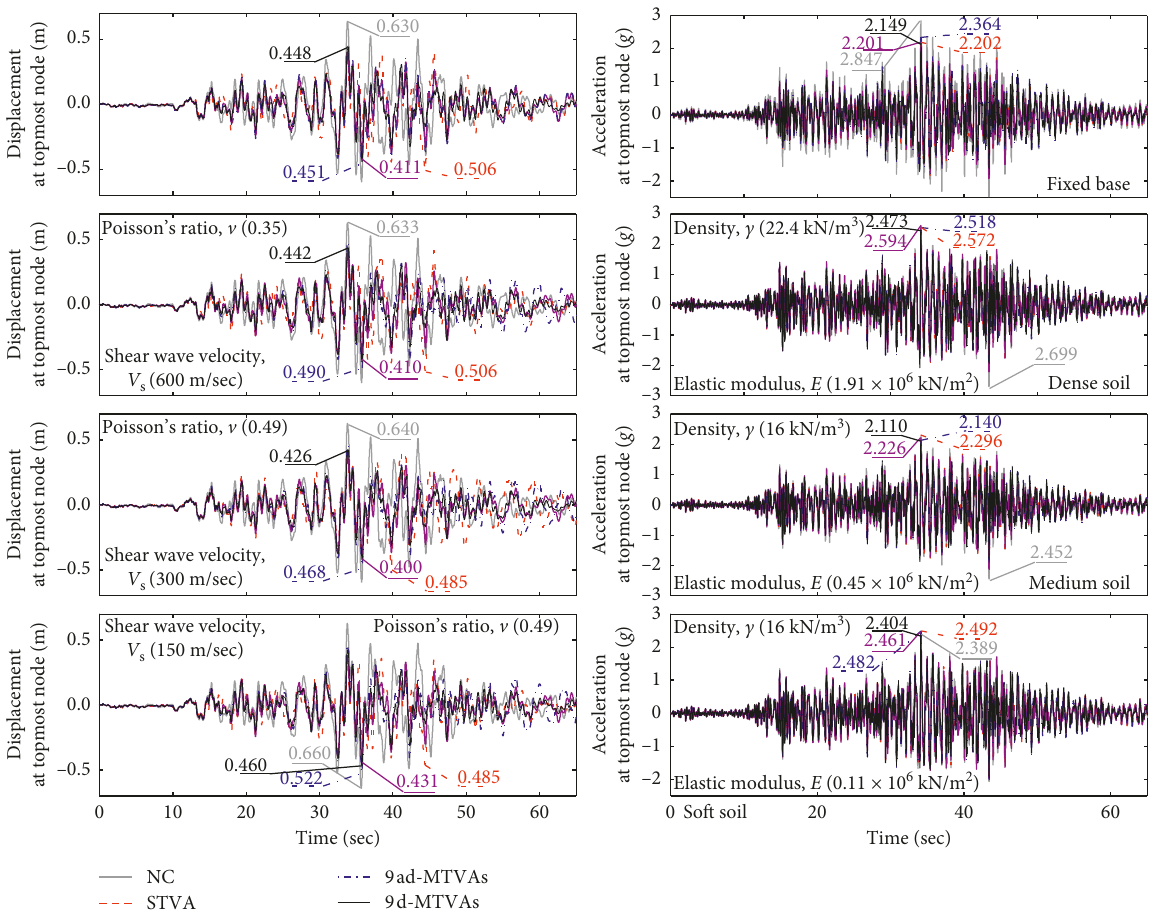
Figure 3: Time variation of displacement and acceleration at the topmost node of the chimney under Llolleo (1985); TVAs are with the mass ratio ( µ ) of 2% and damping ratio ( ζ d ) of